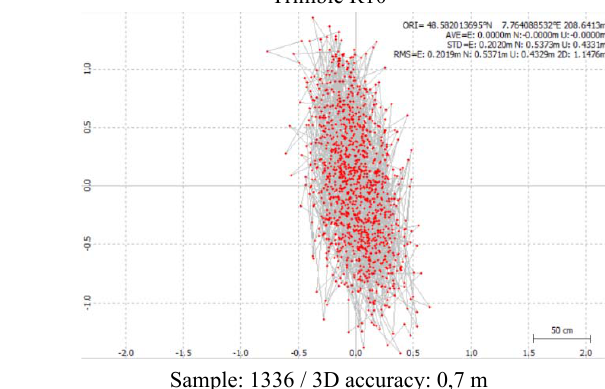
Figure 4 : Comparison of positioning accuracy in stand-alone solution